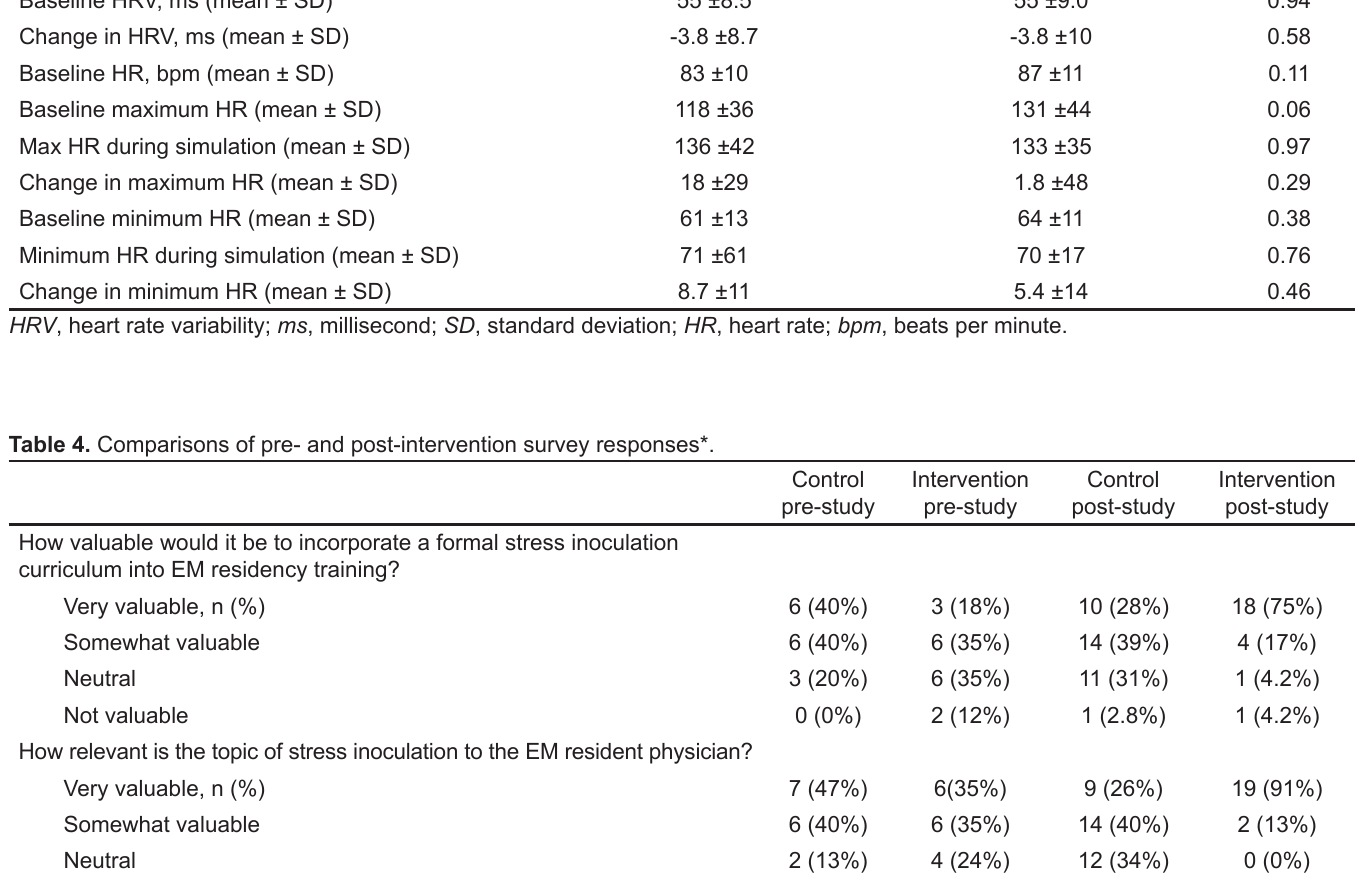
*% is based off the number of individuals who answered each